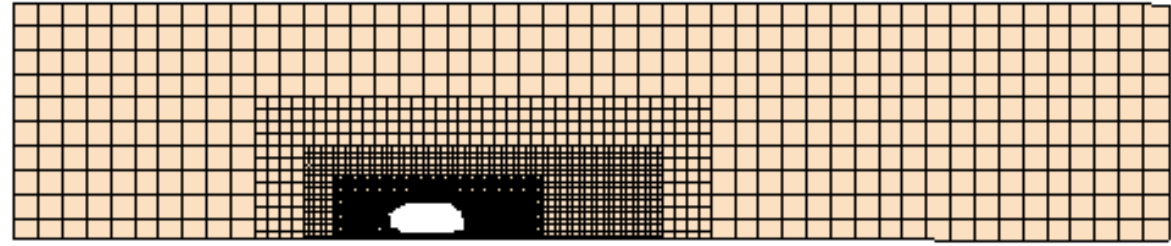
Figure 2. Volume mesh division of the engine compartment: ( a ) engine compartment at the y = 0 m section; ( b ) the enlarged part in the red box.